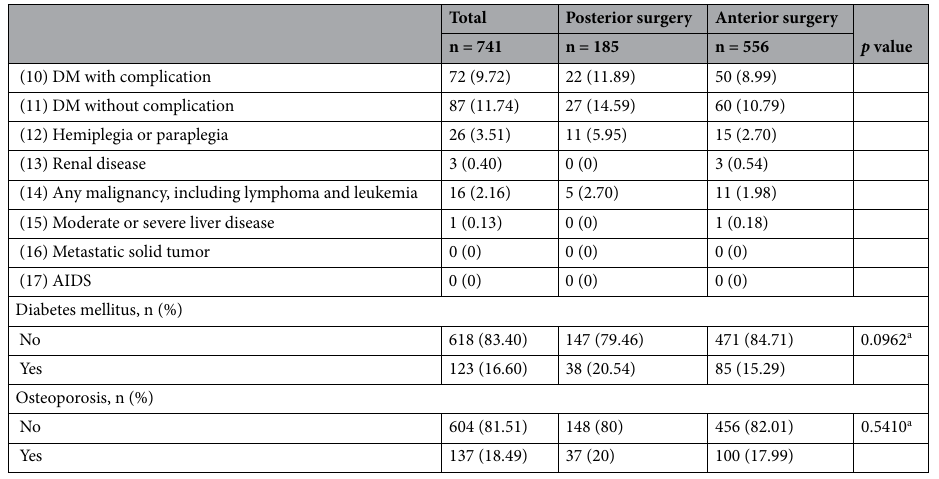
Table 1. Characteristics of the patients. SD standard deviation, DM diabetes mellitus, AIDS acquired immunodeficiency syndrome. a Chi square test. b T-test. c Wicoxon Rank Sum